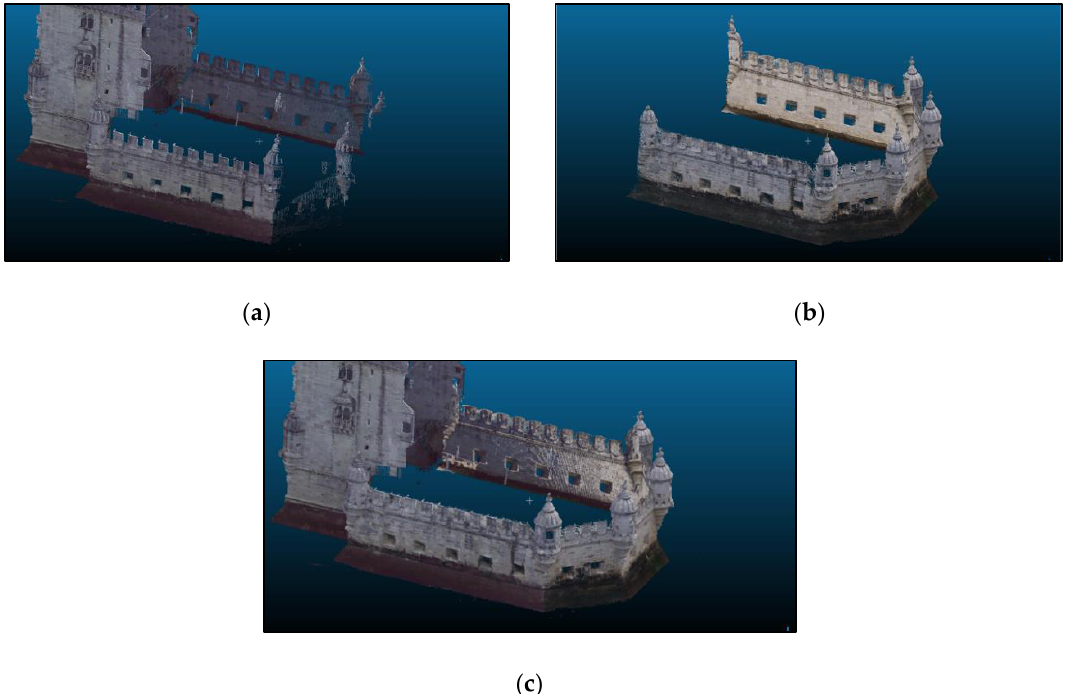
Figure 13. Point clouds from different sources: ( a ) from TLS; ( b ) from close-range photogrammetry; ( c ) same clouds after georeferencing of the photogrammetric point cloud. The upper left corner is pointing North.